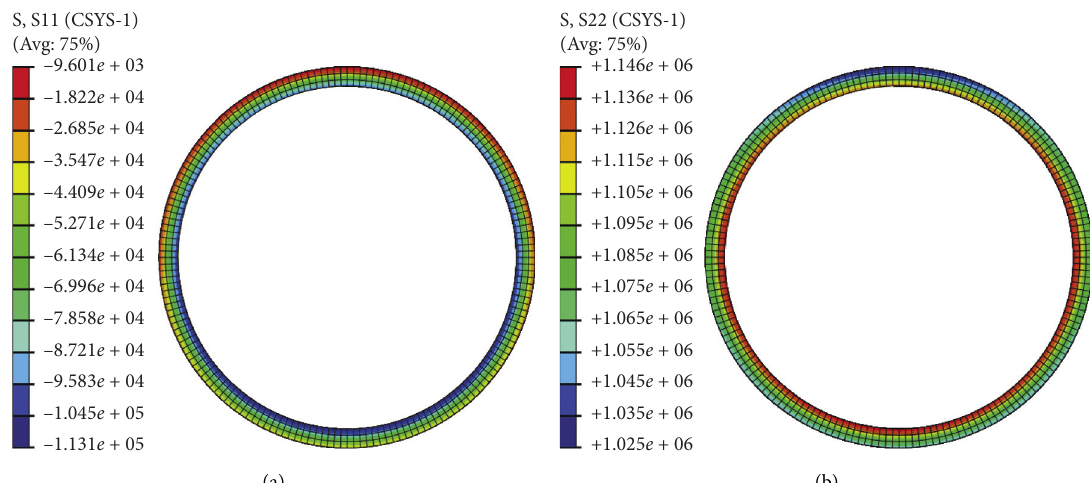
Figure 14: Radial stress (a) and circumferential stress of outer lining (b)